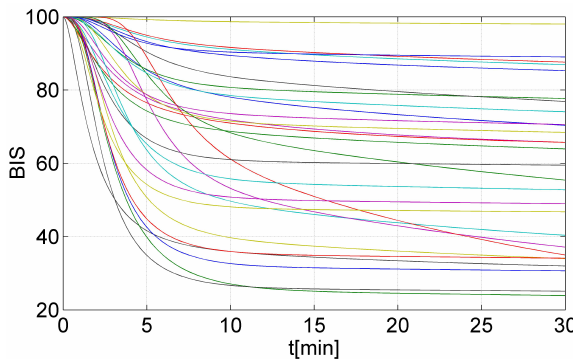
Figure 4. Patient’s response to a step input.